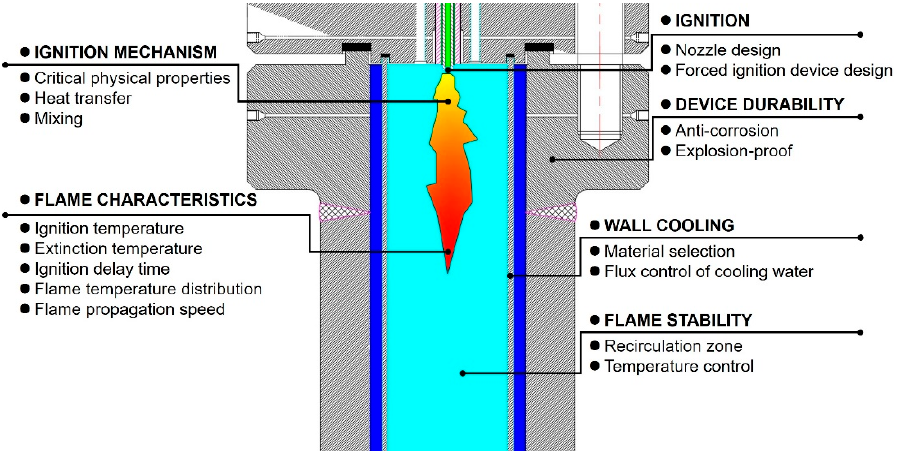
Figure 12. Scientific and technical challenges and applications of SCHC.